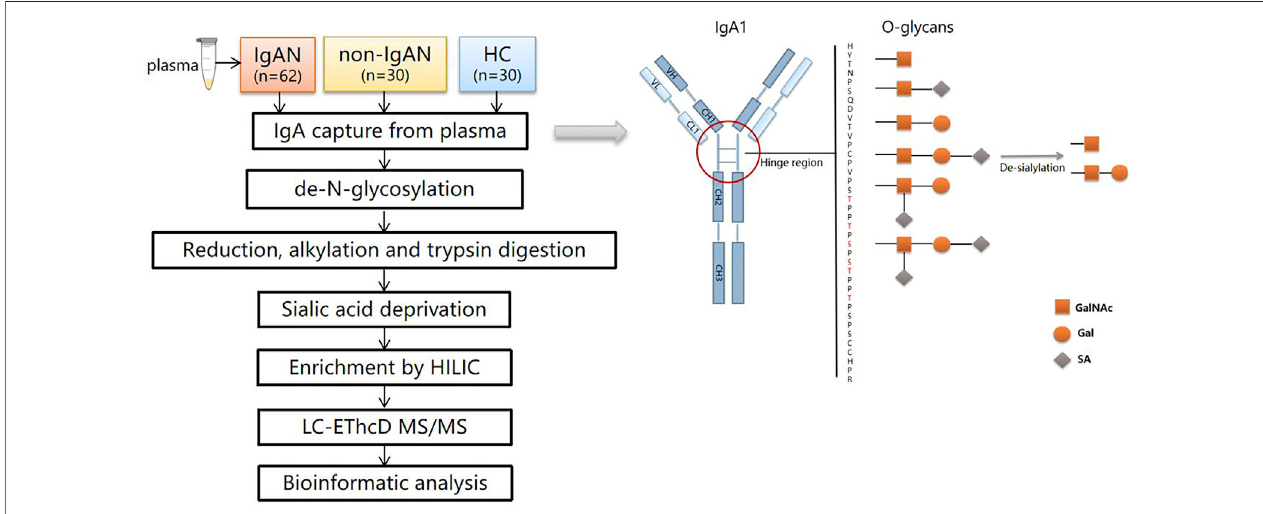
FIGURE 2 | The work fl ow of the study and schematic view of IgA1 O-glycosylation. There are six types of O-glycans in the IgA1 HR consisting of N-acetylgalactosamine (GalNAc), galactose (Gal), and sialic acid (SA). After de-sialylation, two types of monosaccharides were left ( ☐ :GalNAc, O: